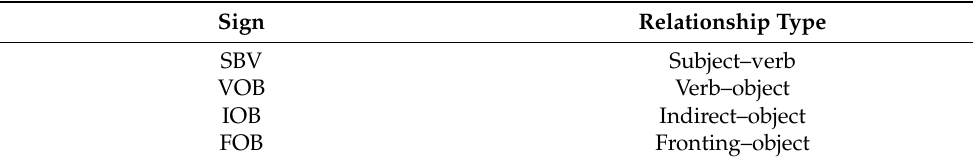
Table 3. Partial dependency tags and